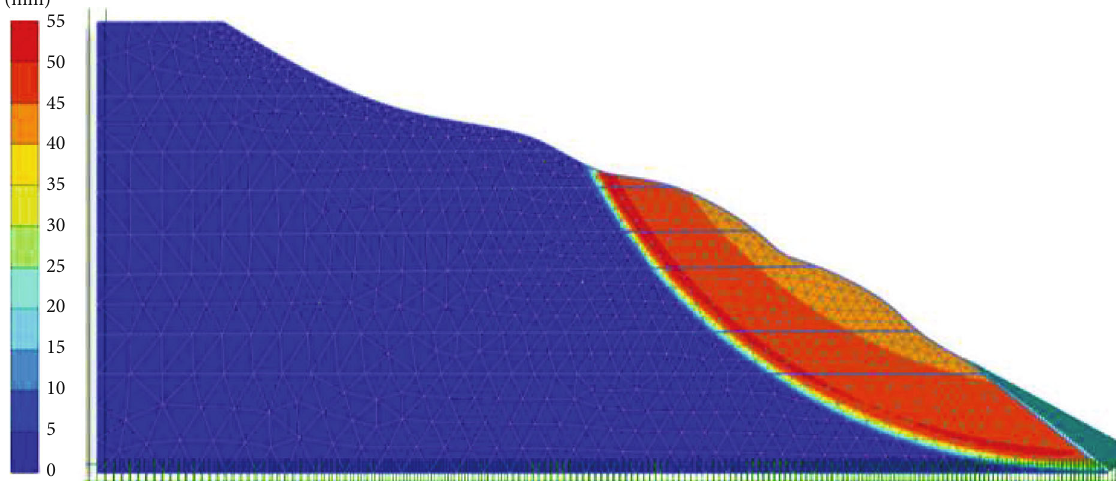
Figure 9: Incremental displacement nephogram of landslide (condition